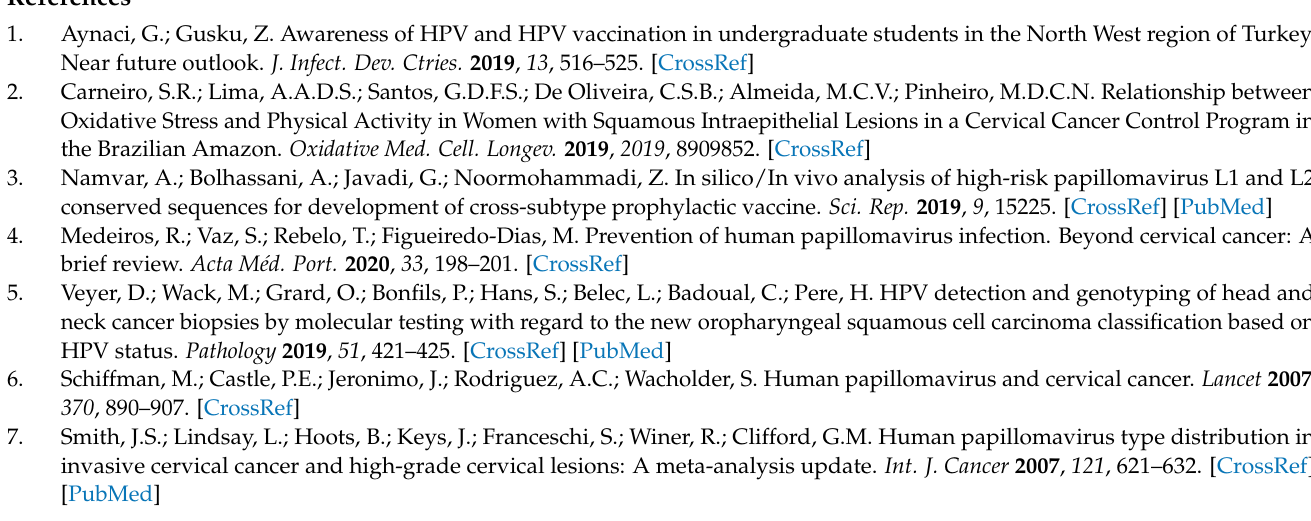
production, Figure S3: Schematic diagram of on-CARD fluid control, Figure S4: Schematic diagram of the principle of detecting HPV, Table S1: Primer sequences of 24 HPV genotypes and internal reference (GB), Table S2: Probe sequences of 24 HPV genotypes, Table S3: The remaining reagents contained in the matching detection